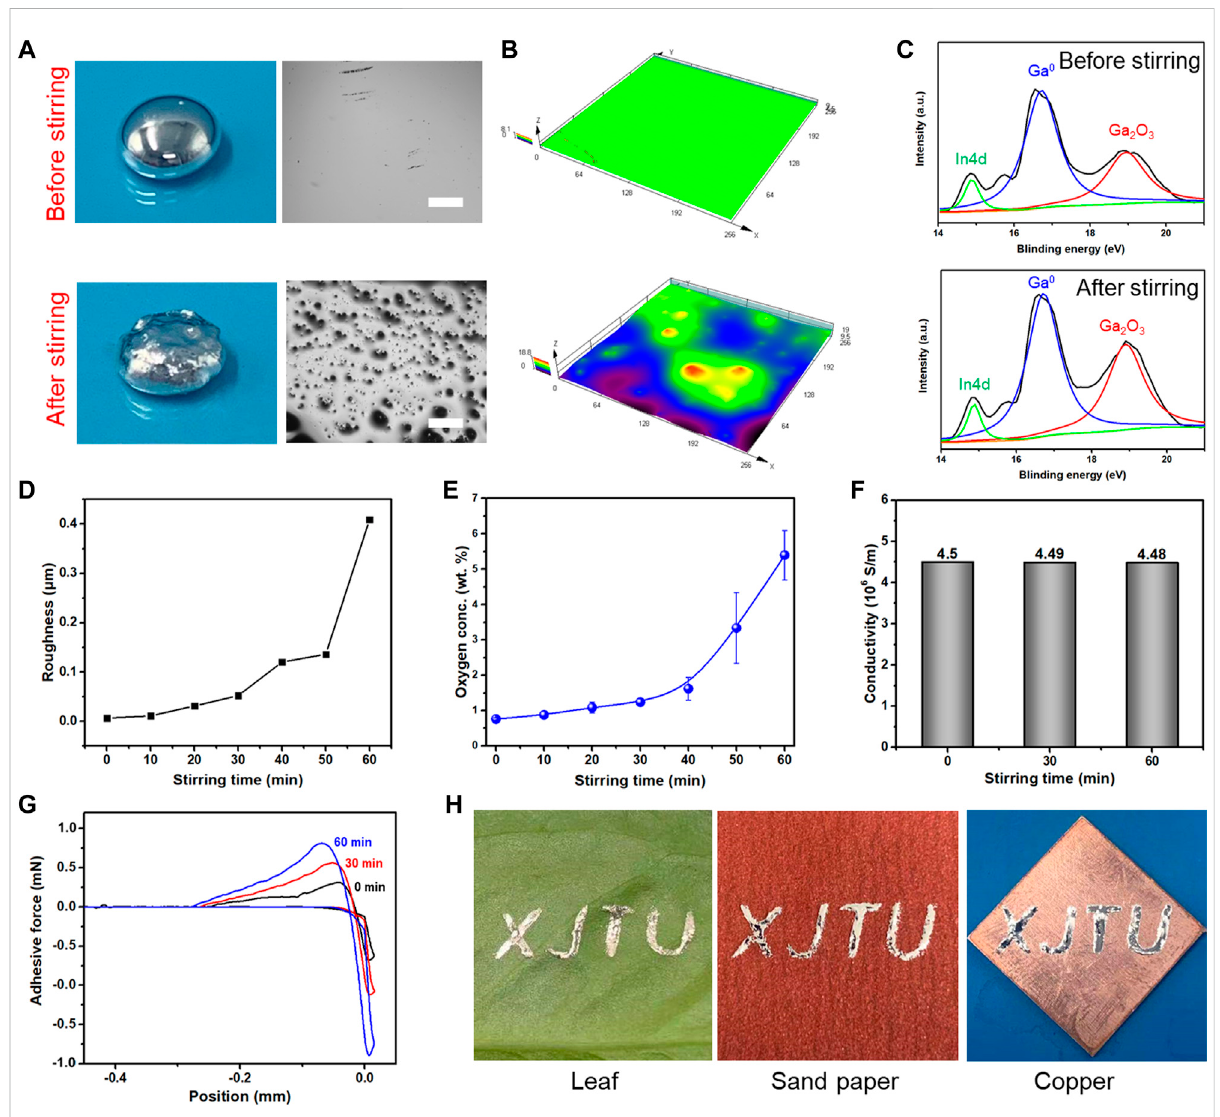
ComparisonbetweenoriginalandmagneticstirredEGaIndroplets. (A) Photographsofthedropletsandtheirsurfaces,scalebar:500 μ m. (B) 3D confocal microscopy images of EGaIn and O-EGaIn surfaces. (C) XPS analysis of EGaIn and O-EGaIn surfaces. (D) Surface roughness of EGaIn with different magnetic stirring times. (E) Relationship between oxygen contents of EGaIn and magnetic stirring time. (F) Conductivity of EGaIn with different stirring times. (G) Adhesive force between fl at PDMS surface and EGaIn droplet with different stirring times. (H) O-EGaIn as electronic direct ink writing on different